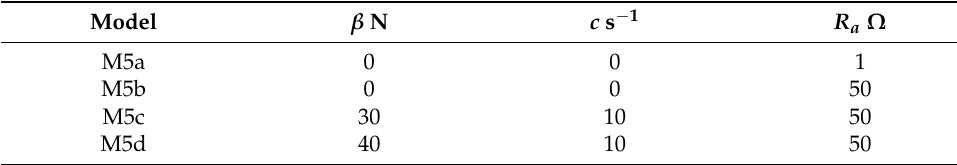
Table 3. Parameters of the semiactive and active model of the